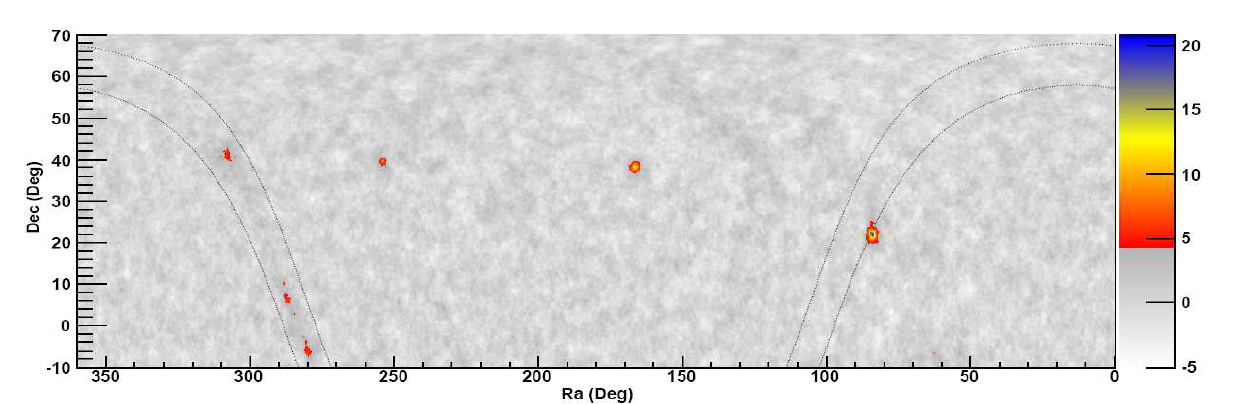
Figure 2: Significance map of the northern sky as seen by the ARGO-YBJ experiment in VHE γ -ray band. The two dotted lines indicate the Galactic latitudes b = ± 5 ◦ .